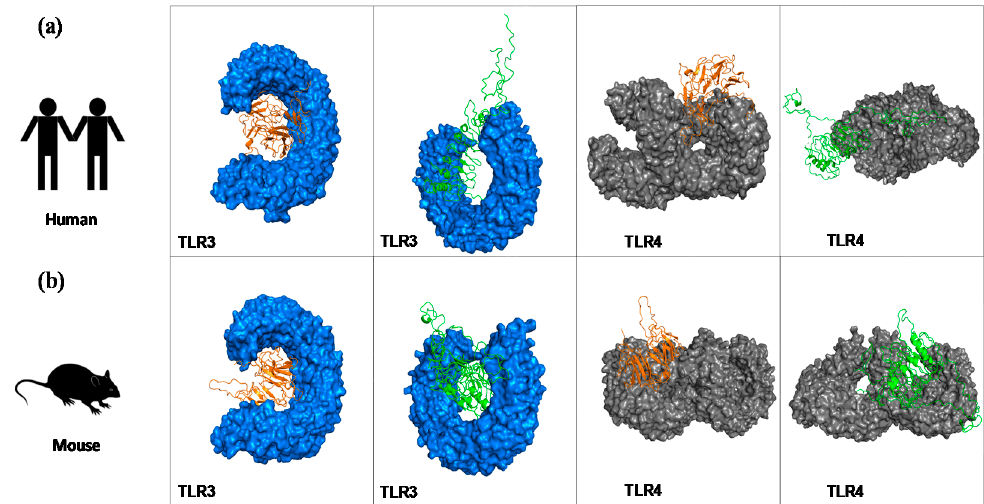
Figure 2. Interaction of refined models for chimeras A and B with toll-like receptors using molecular docking (ClusPro2.0 web server) . Representation of the best docked-complex between chimeras and human ( a ) and mouse ( b ) toll-like receptor (TLR)3 (blue) and TLR4 (grey). Chimera A (a) is represented by orange, chimera B is represented by green.